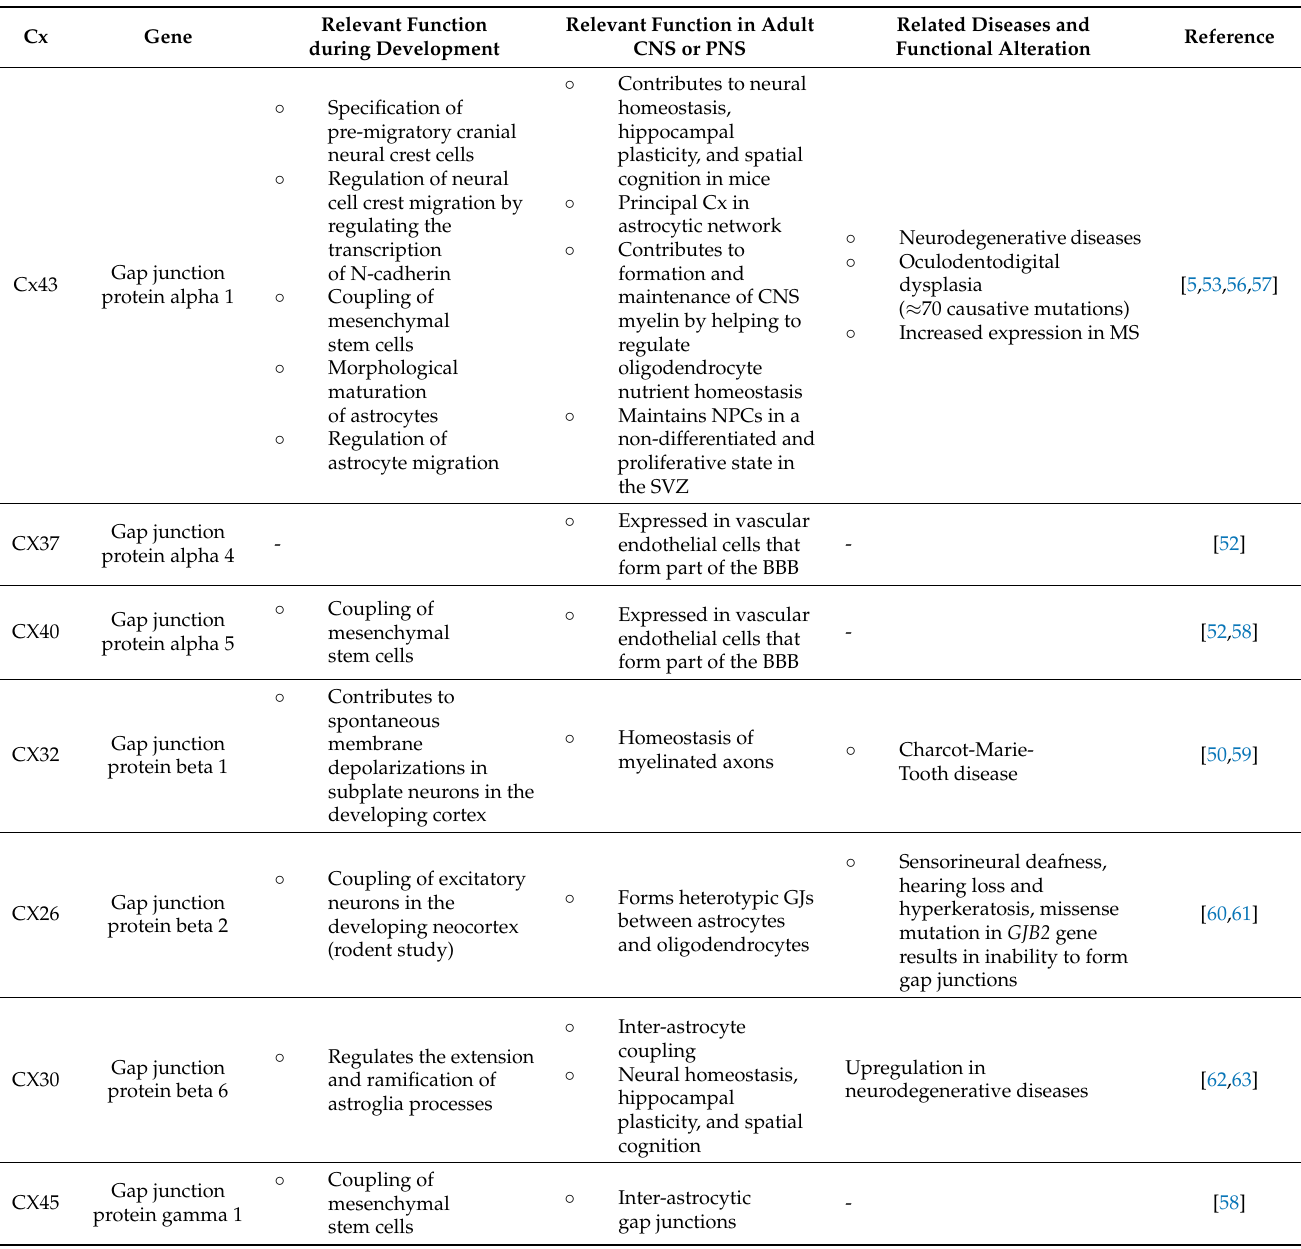
Table 1. Functions of the relevant Cxs expressed during development, in the adult brain, and related neurological